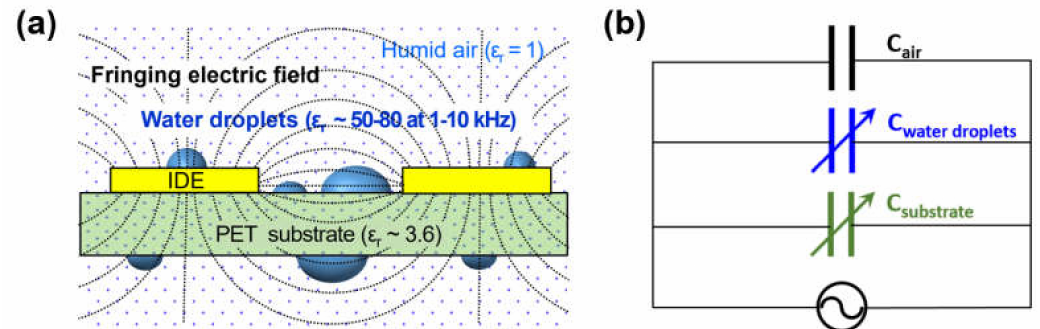
Figure 10. ( a ) The schematic illustration and ( b ) the equivalent circuit model of the mechanism for the effects of surface water wettability and operating frequency on the response linearity of IDE capacitive humidity sensor with PET substrate (the relative permittivities of materials are the estimated values at 1–10